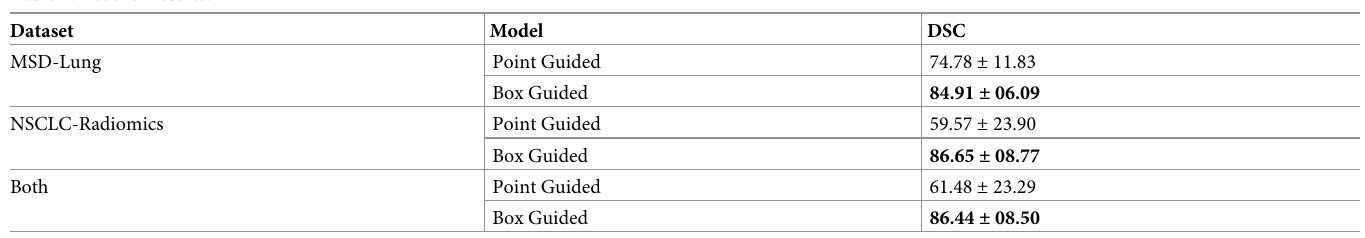
Table 2. Teacher results. Dataset